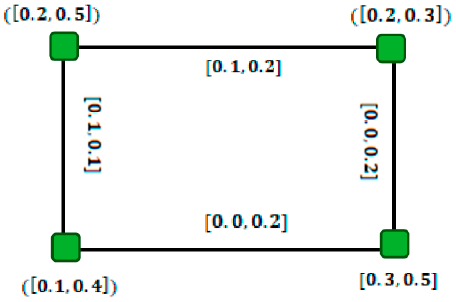
Figure 12. Complement of graph depicted in Figure 8.